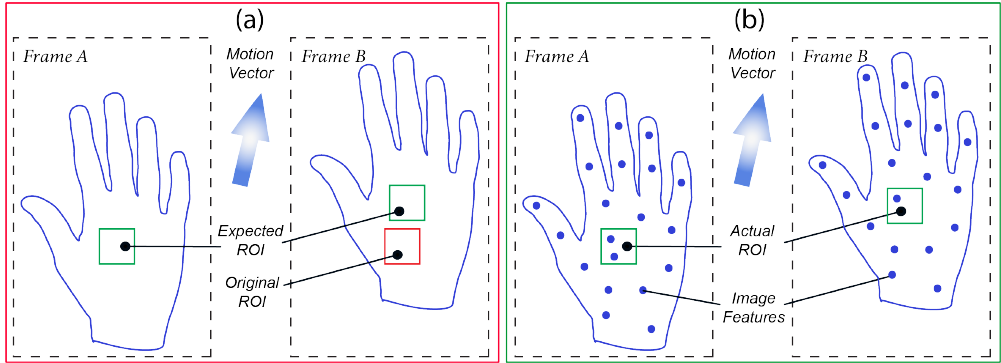
Figure 2. ( a ) Without image registration. The motion vector of the palm w.r.t. the camera sensor shifts the ROI away from its expected location in Frame B . ( b ) With image registration. A motion vector was computed and the shift was compensated by tracking the ROI to its actual position in Frame B , even though the object’s coordinates have changed in comparison to Frame A . Image features, such as hair follicles, deep wrinkles, birthmarks, or skin imperfections may be used to facilitate motion